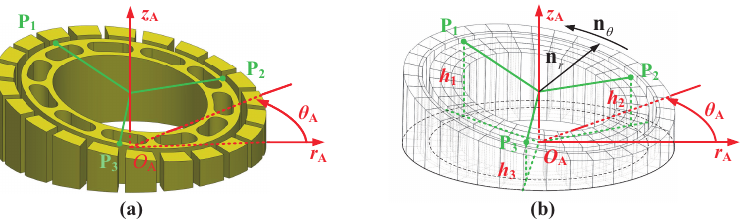
Figure 4. The coordinate system and meshes of the oil film. ( a ) The coordinate system. ( b ) The